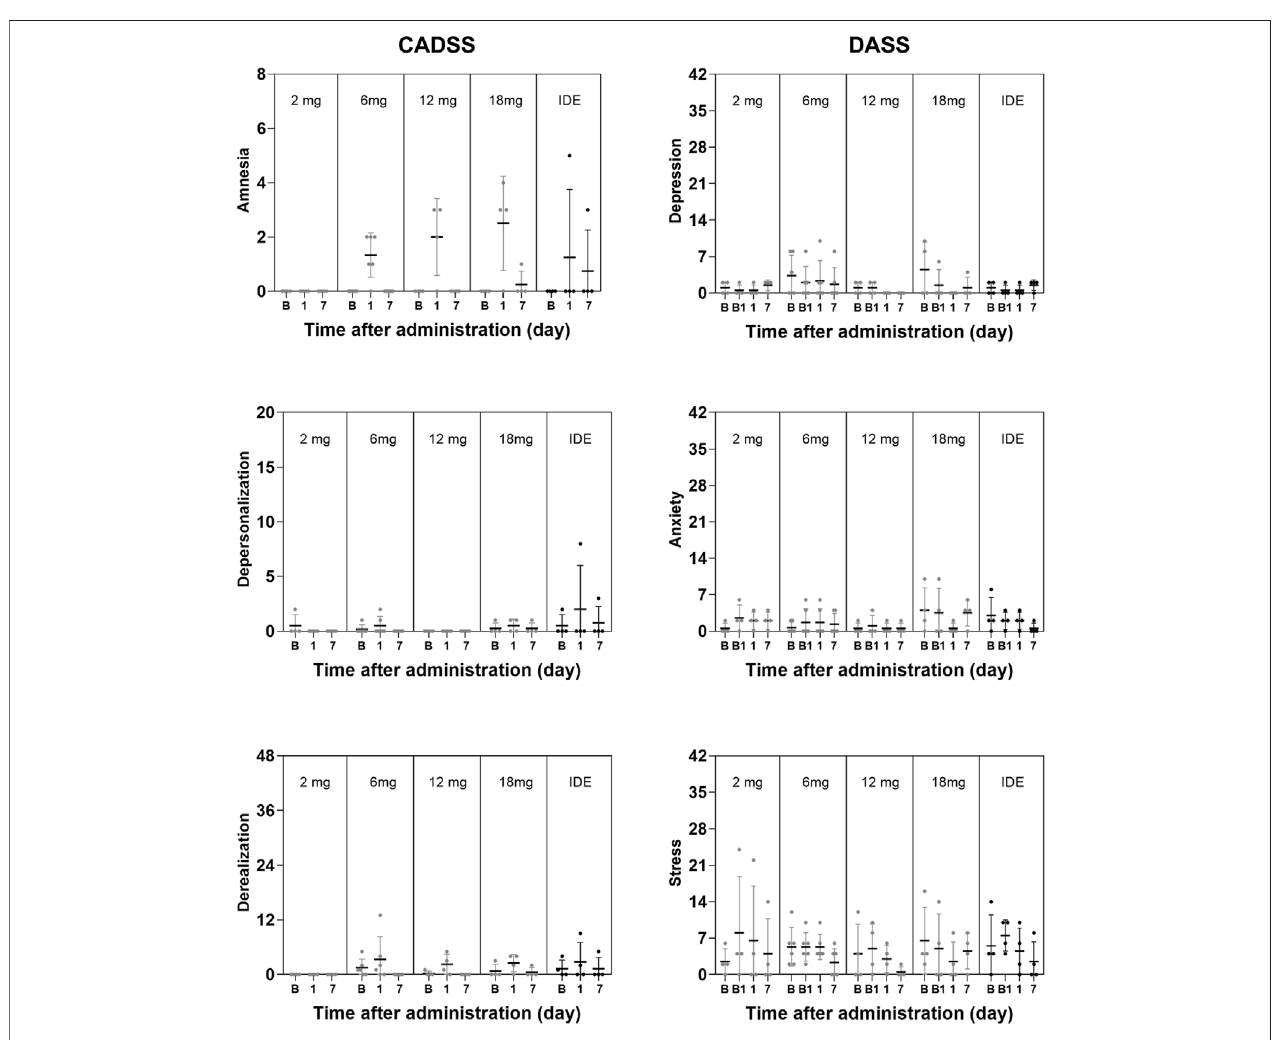
FIGURE 3 | Mean (SE) and individual CADSS and DASS ratings per dose